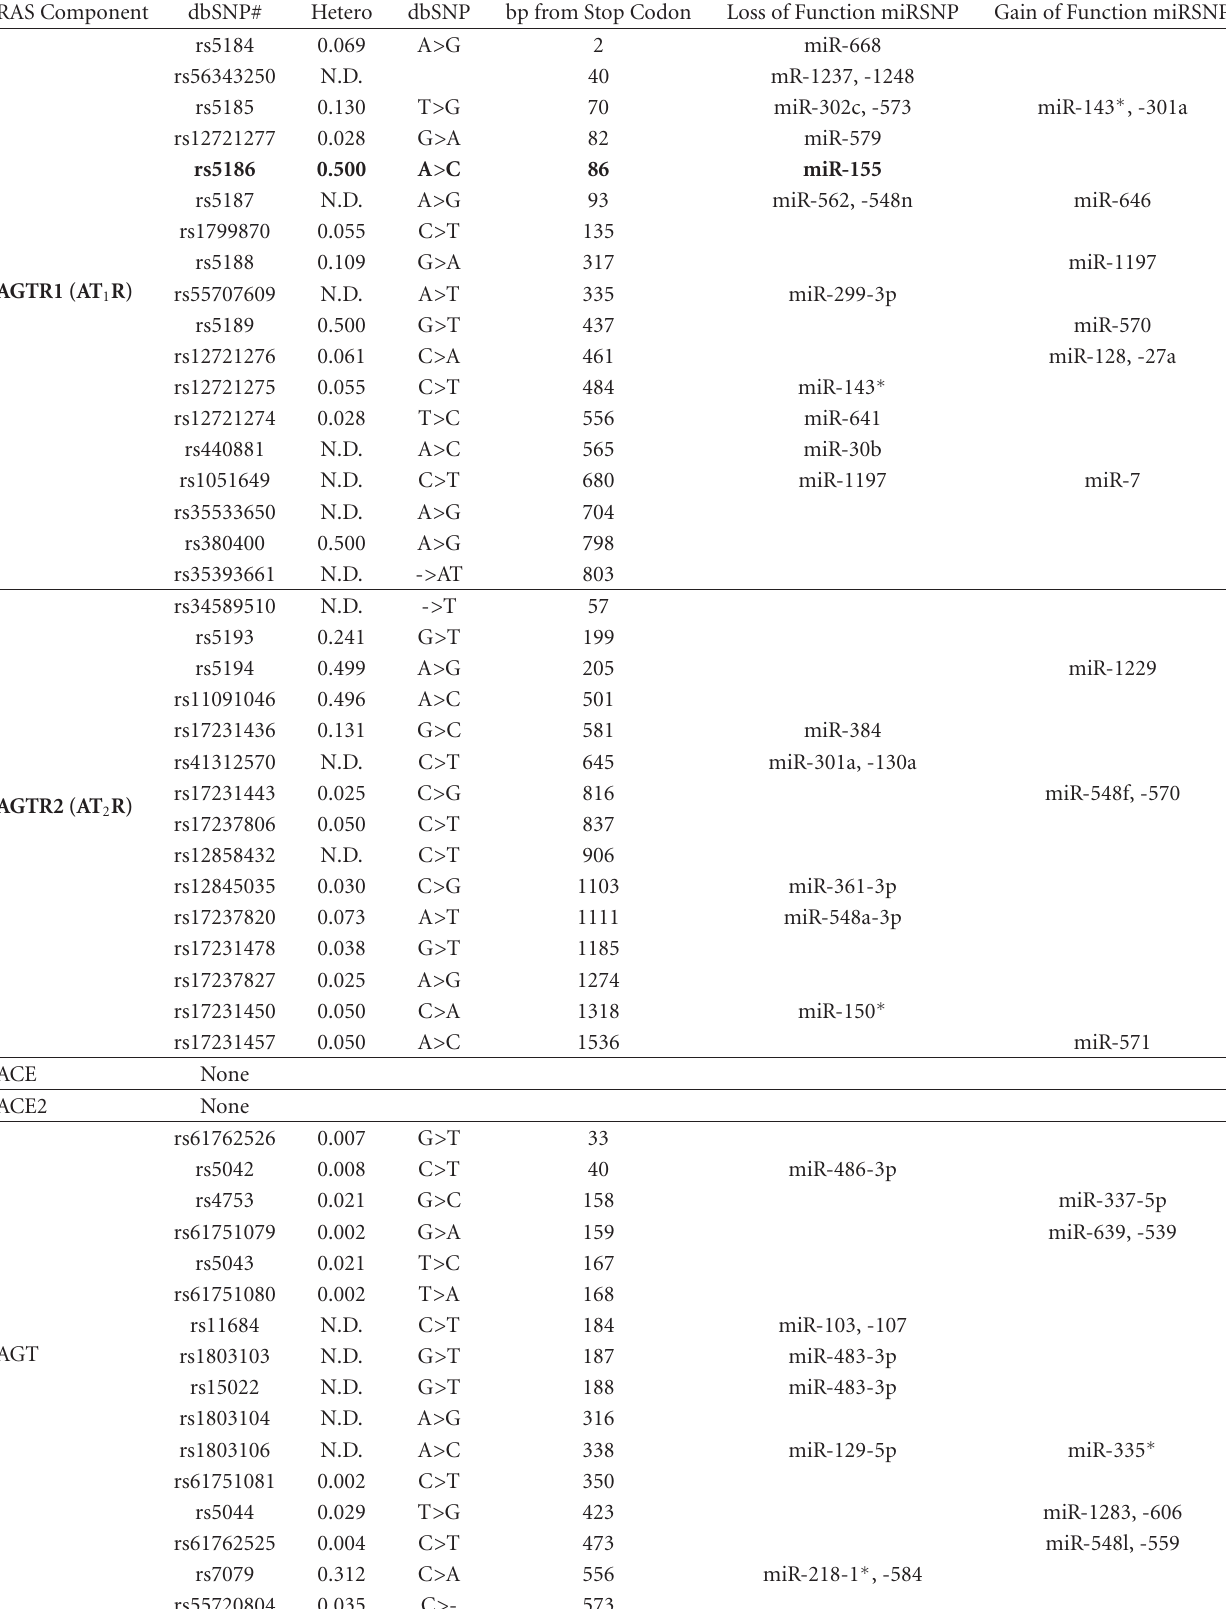
Table 2: Patrocles ∗ algorithm-predicted RAS component